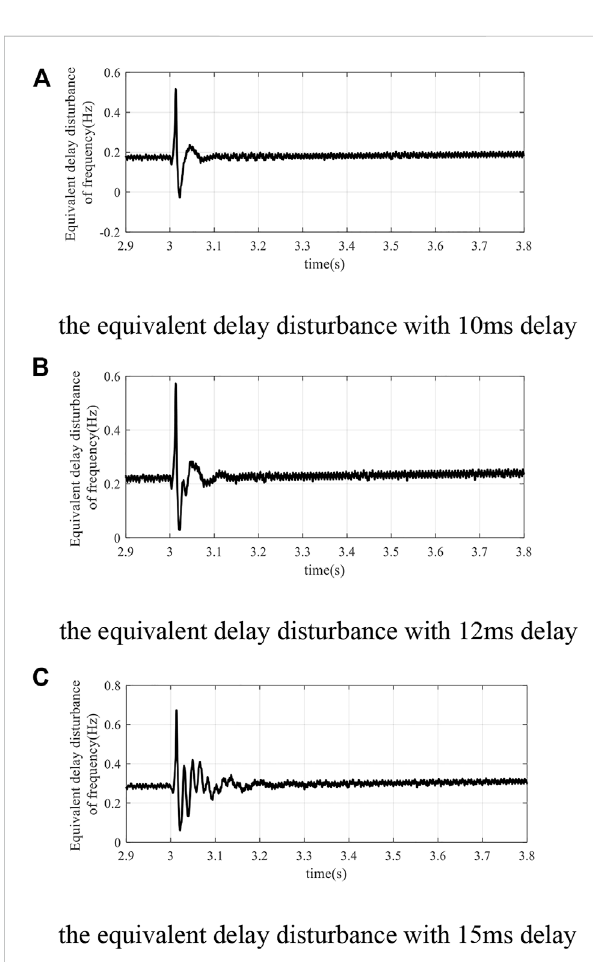
FIGURE 10 The simulation results of the equivalent delay disturbance of frequency. (A) the equivalent delay disturbance with 10 ms delay, (B) the equivalent delay disturbance with 12 ms delay, (C) the equivalent delay disturbance with 15 ms